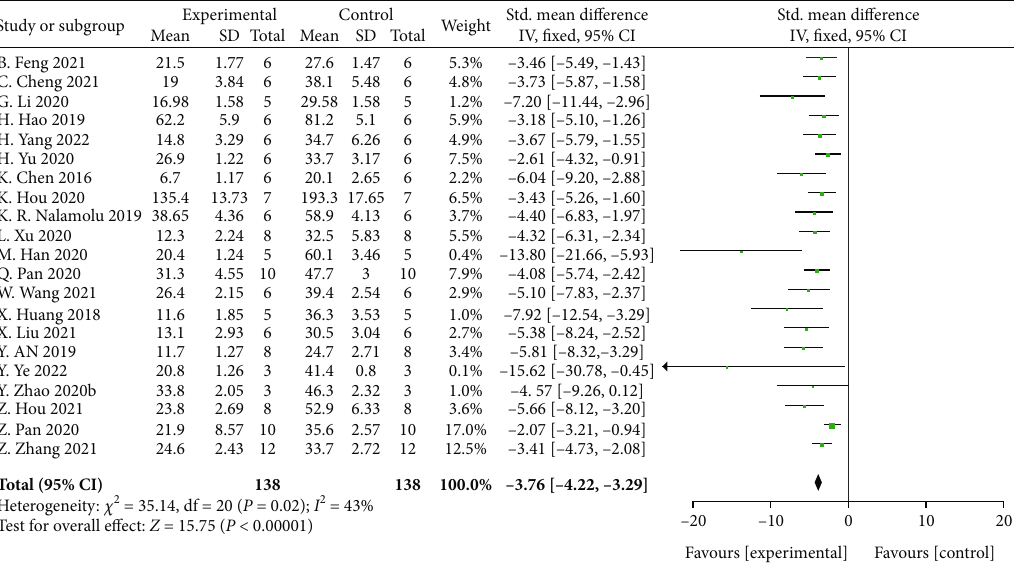
Figure 2: The forest plot: e ff ects of MSCs-derived sEVs for decreasing the cerebral infarction size compared with control group.